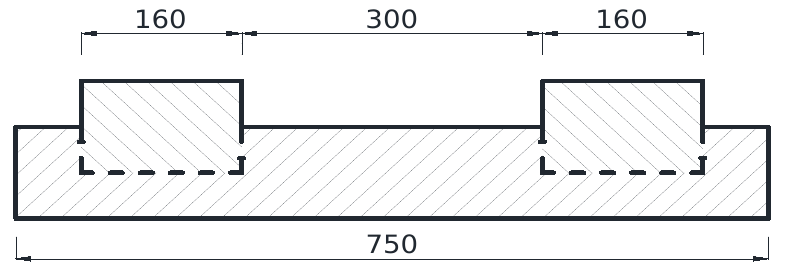
Figure 8. Cross-section of the laboratory sample (dimensions are described in mm).